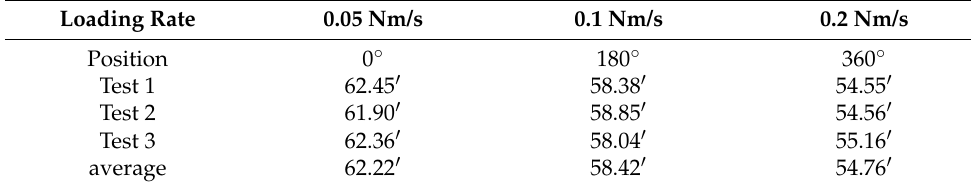
Table 6. Experiment results of δ e